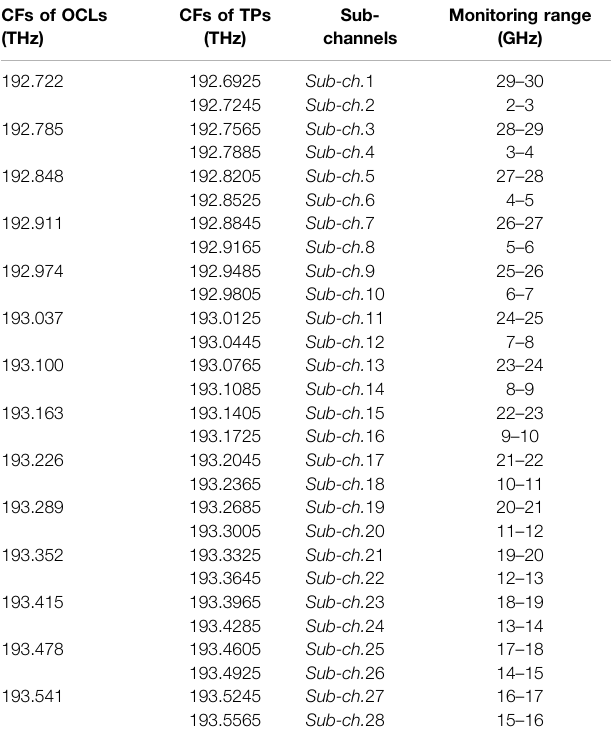
TABLE 2 | Relationship among OCLs, TPs, sub-channels, and monitoring bands for dynamics 4 GHz signal. CFs of OCLs CFs of TPs (THz) (THz)